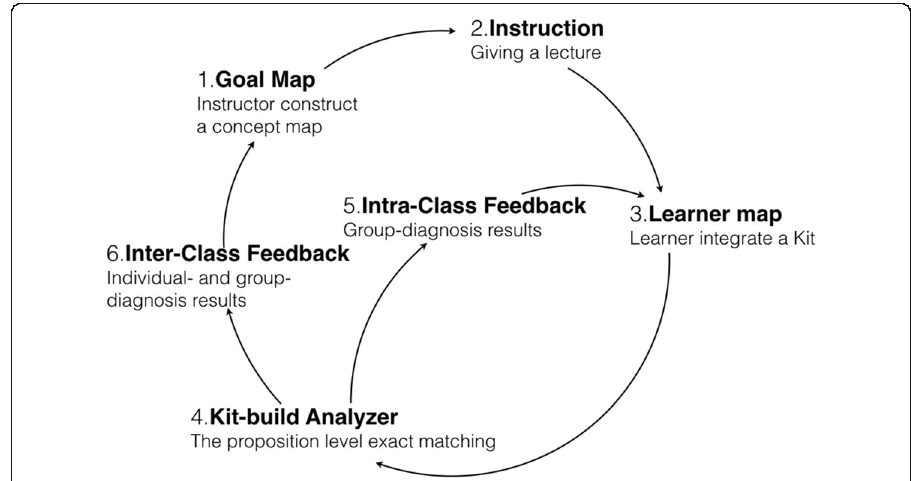
Fig. 5 A cycle of the Kit-Build concept map on formative